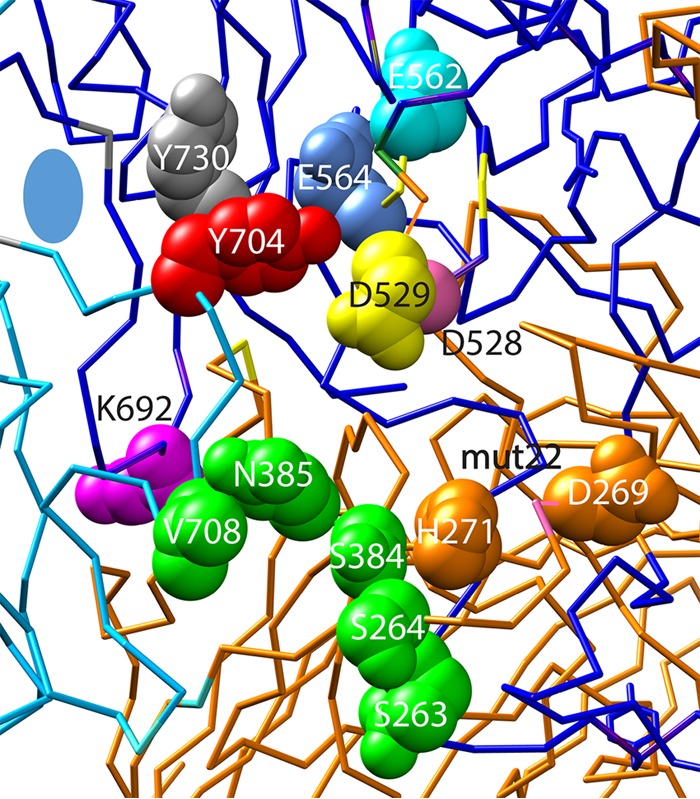
Positions of the mutations in the 30-Å-diameter dead zone. The relative positions of the E562 (cyan), E564 (blue), D528 (yellow), D529 (pale red), and K692 (purple) mutants and the double mutant mut22 (H271 D269) (orange), which were characterized in this study, are shown on the atomic structure of AAV2. The wt amino acids that were mutagenized are shown as space-filling molecules on one side of the 2-fold interface (blue oval) on the peptide chain backbone of this region of the capsid. The dark blue and cyan chains form the 2-fold interface. The orange peptide chains form a 3-fold interface with the reference blue chain. Also shown are the residues (green) that were previously shown to be involved in binding to the A20 antibody (3). In addition, Y704 (red) was previously shown to eliminate transcription when converted to an alanine residue (6), and Y730 (gray) was previously shown to increase transduction when converted to a phenylalanine residue (7).